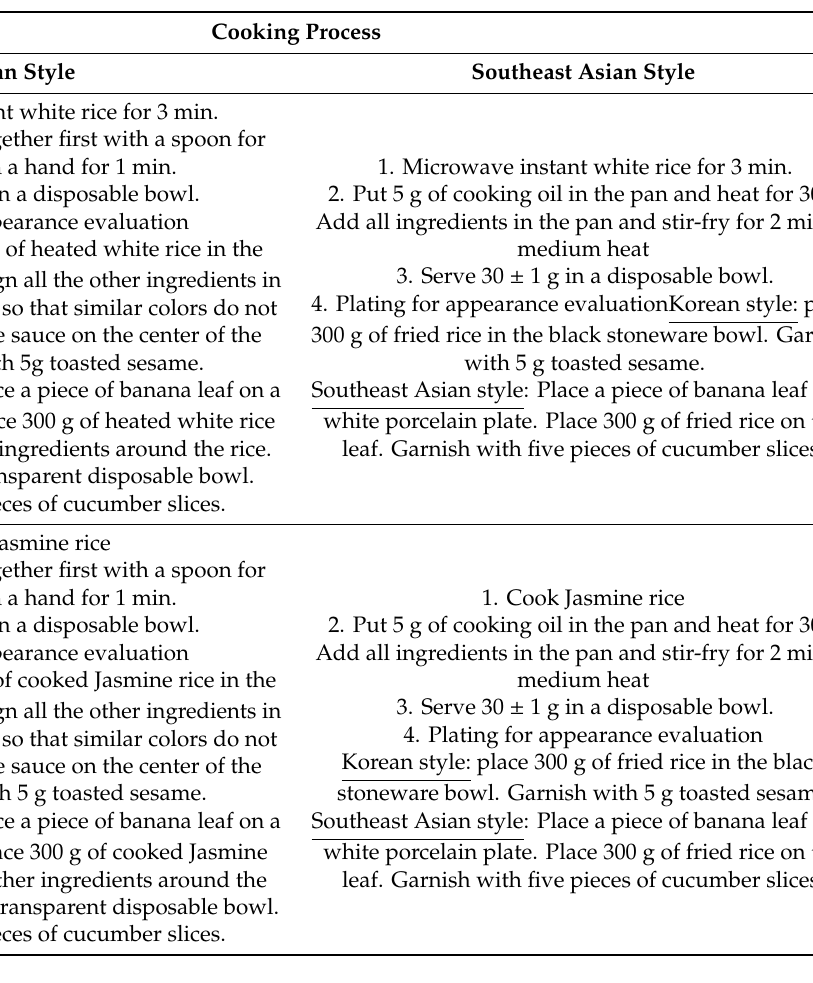
Table A1. Preparation Procedure of the